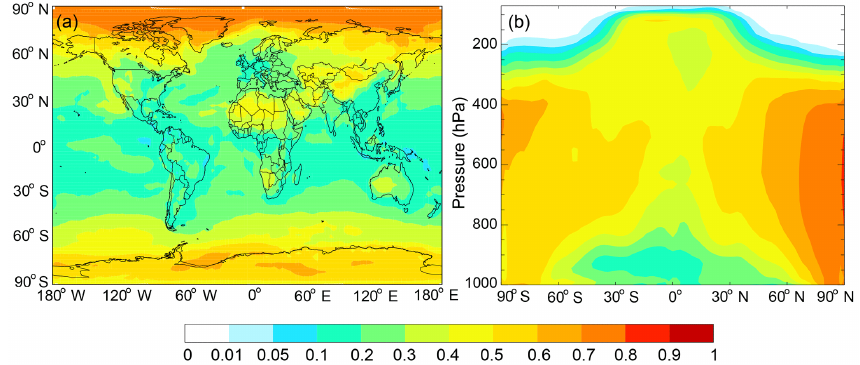
Figure 10. GEOS-Chem simulated annual mean contribution of chemical oxidation to the total BC aging rate (sum of condensation, coagu- lation, and chemical oxidation) averaged within 0–1km above the surface (left) and zonally (right). Model results are for